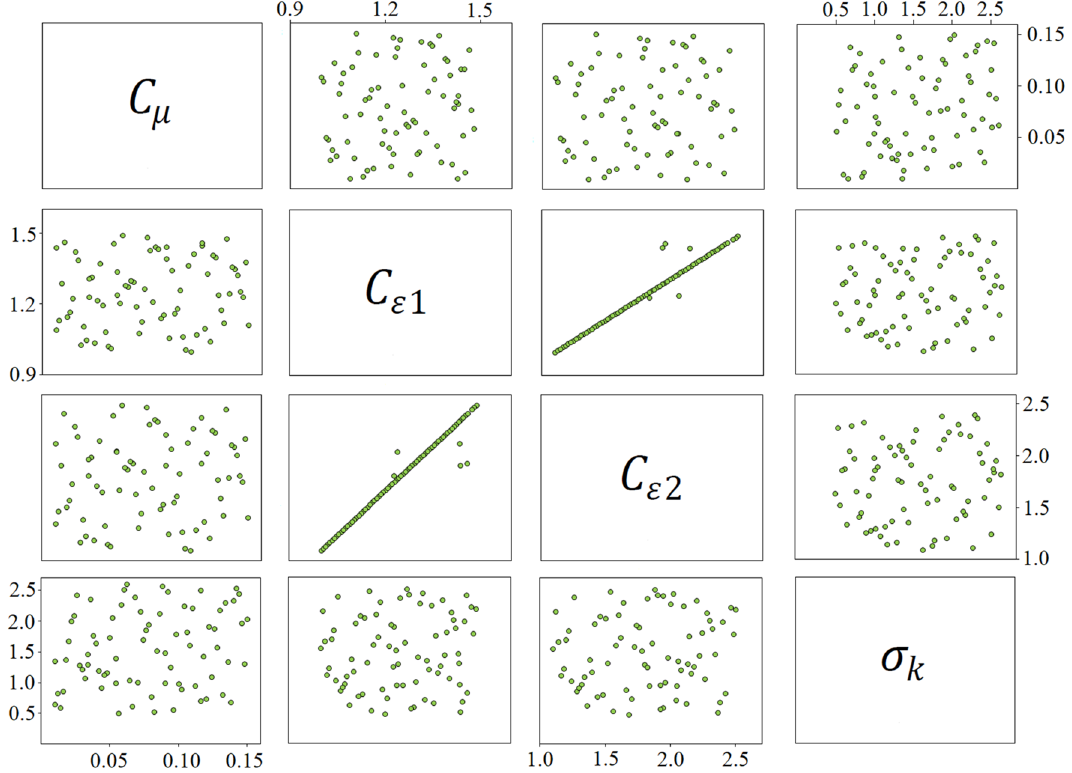
Fig. 7 Distribution of the turbulence model parameters for regression